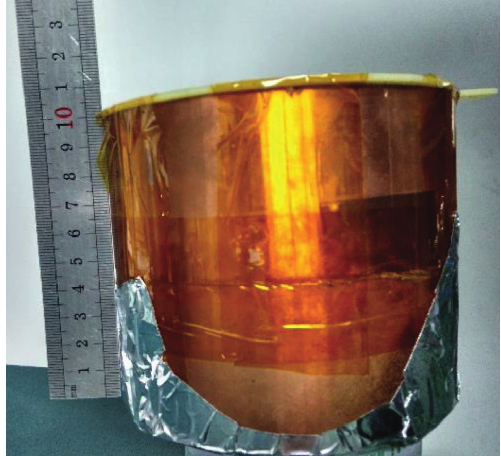
Figure 21: Prototype of the SAAS antenna with a back cavity.